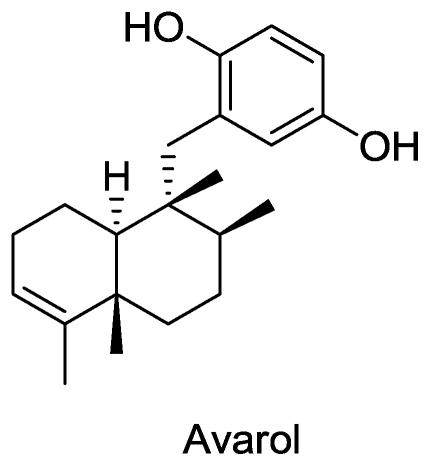
Structure of avarol.